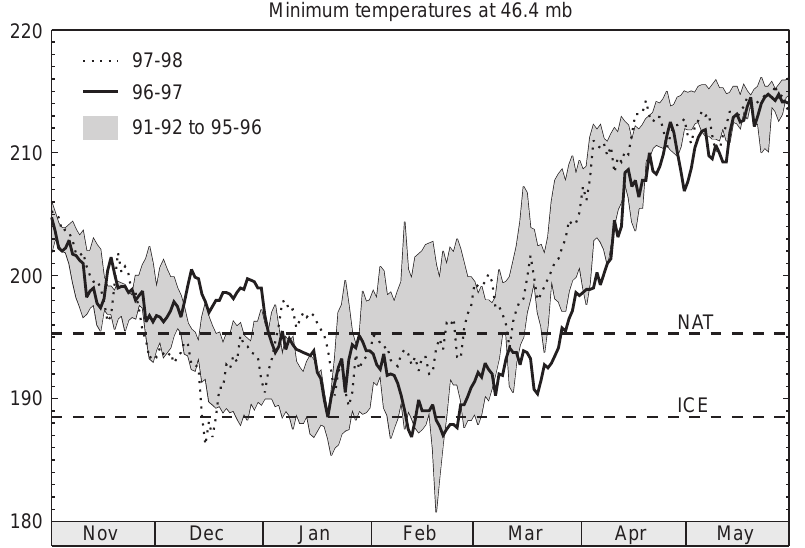
Fig. 4. Minimum temperatures for the region north of 45 (cid:14) N from UK Meteorological O(cid:129)ce stratospheric analyses. The shaded region shows the range of minimum values for each day for the periods 1/11/1991–31/5/1992 to 1/11/1995–31/5/ 1996. The values for the period 1/11/1996–31/5/ 1997 and 1/11/1997–31/5/1998 are indicated by the solid and dashed lines . For comparison the thermodynamic equilibrium temperatures for the formation of nitric acid trihydrate ( NAT ) and pure ice ( ICE ) PSCs are indicated by the broken lines parallel to